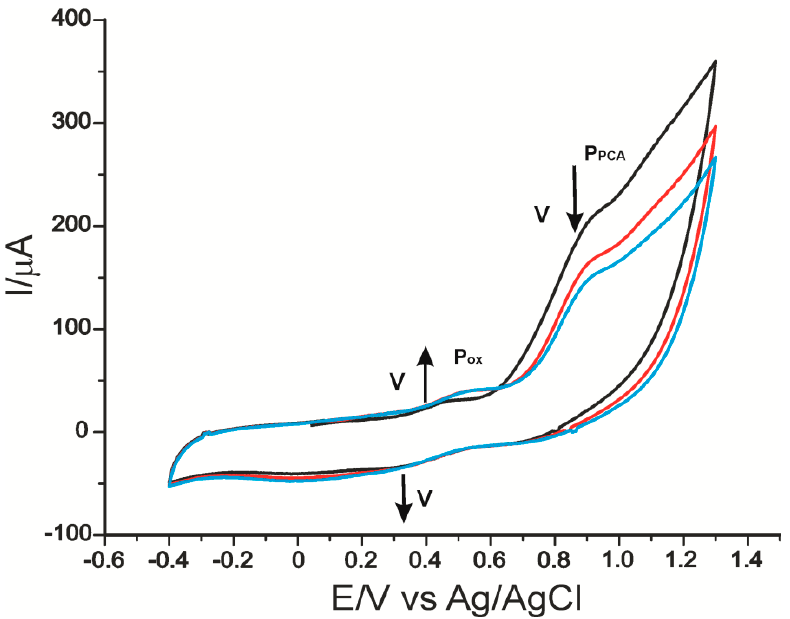
Figure 5. Cyclic voltammograms of CNF-CoPc-Lac/SPE immersed in p-coumaric acid solution 10 − 3 M (PBS 0.1 M electrolyte, pH = 5.0): first scan (black line), second scan (red line), and third scan (blue line).